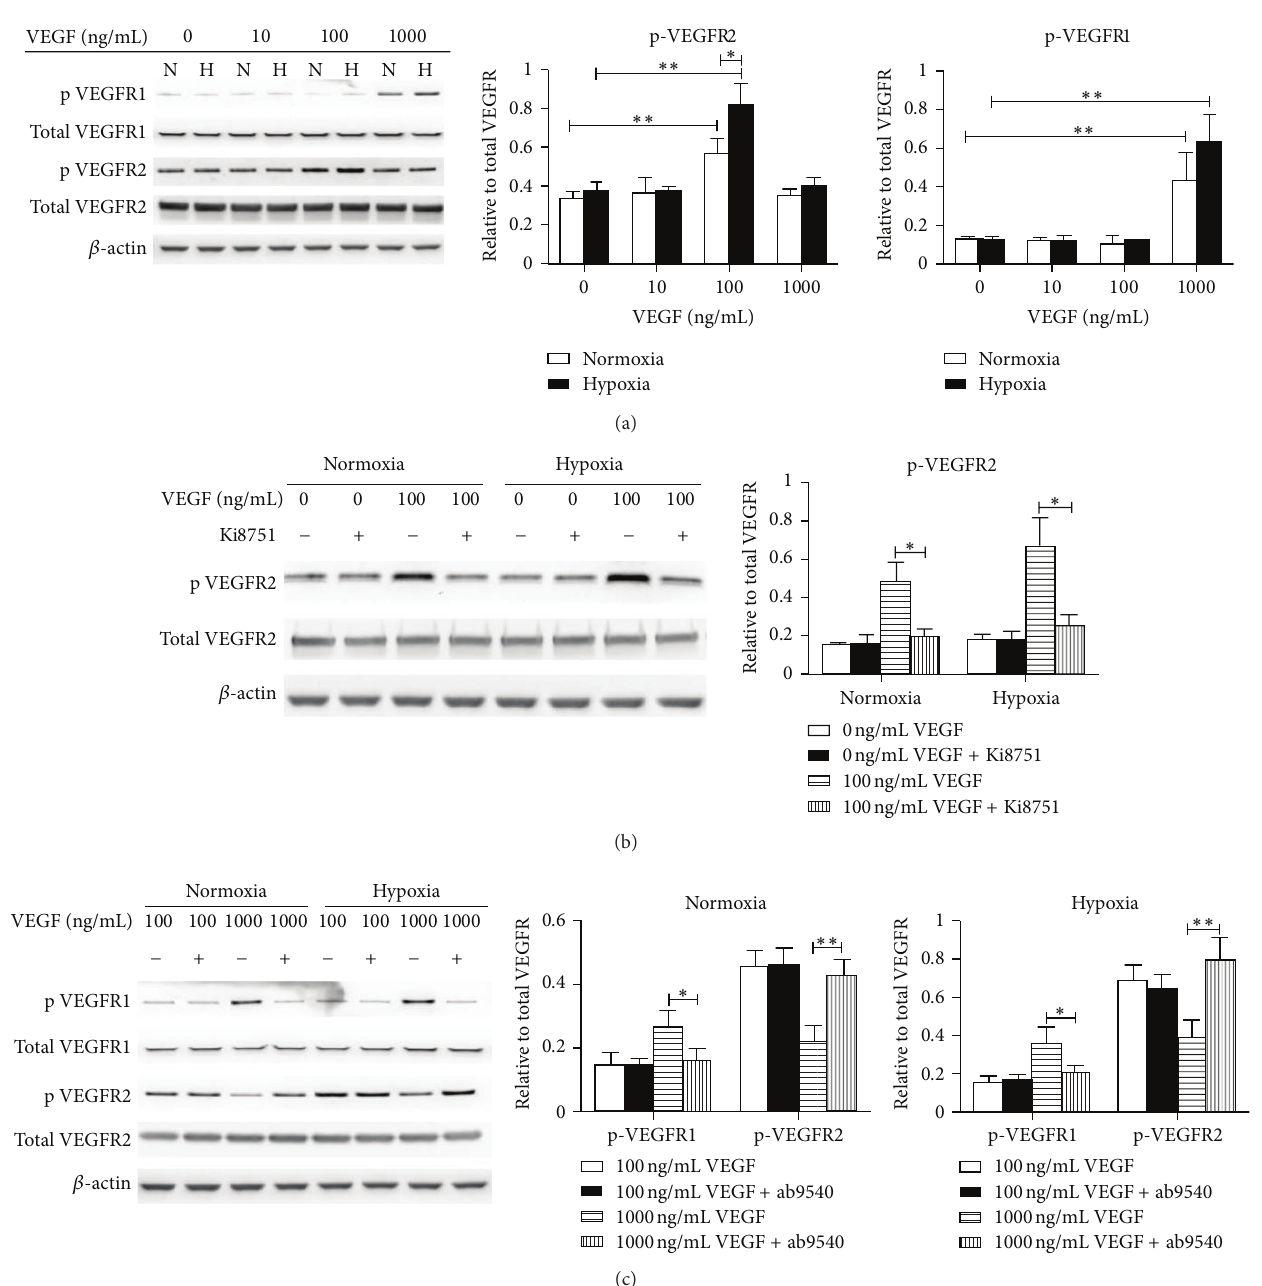
Figure 3: Effect of VEGF on VEGFR expression. GBSCs were treated with the indicated concentration of VEGF in the presence or absence of the VEGFR inhibitor or antibody. The levels of total VEGFR1 and VEGFR2 protein and the levels of phosphorylated VEGFR1 and VEGFR2 were determined by Western blot analysis and expressed relative to 𝛽 -actin protein level. Phosphorylated VEGFR1 and VEGFR2 protein levels were normalized to total VEGFR1 and VEGFR2, respectively. Values represent the mean ± SD of three separate experiments. The statistical significance in comparisons between the different groups is indicated using the capped lines (N = normoxia, H = hypoxia; ∗ 𝑃 < 0.05 , ∗∗ 𝑃 < 0.01